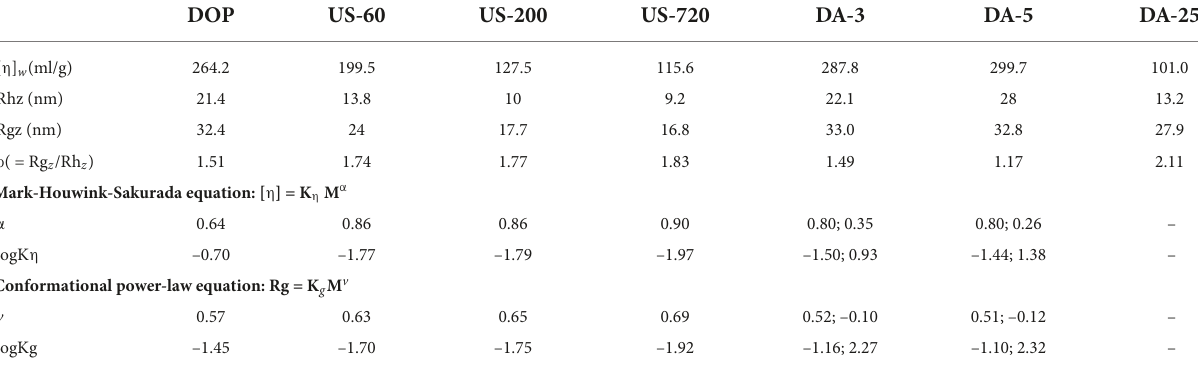
TABLE 2 Conformational characterizations of native and modified DOPs. DOP US-60